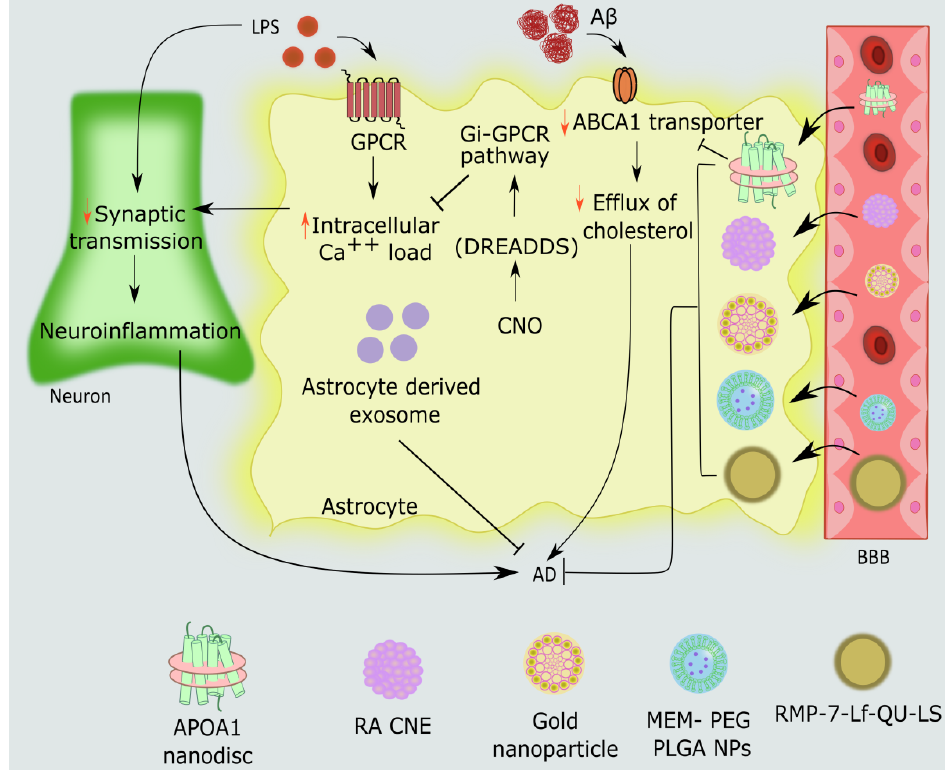
Figure 4. Novel therapeutic strategies to target astrocyte dysfunction in Alzheimer's disease. Reactive astrocytes are brought on by the administration of A β 1–42, and as a result, the levels of the ABCA1 transporter are lowered, inhibiting the release of cholesterol from astrocytes, and hence impeding cholesterol export. When APOA1 nanodiscs cross the BBB, they improve ABCA1 transporters, preventing the reduction of cholesterol efflux in astrocytes caused by exposure to A β 1-42. LPS disrupts the Gi-GPCR pathway, which in turn causes astrocytes to have significantly higher intracellular calcium levels and the accompanying neuroinflammation. Chemogenetic stimulation of the astrocytic Gi pathway by Gi- DREADD agonist CNO reduces intracellular calcium load in hippocampal astrocytes and concomitant neuroinflammation, which enhances synaptic transmission and prevents AD. MEM-PEG-PLGA nanoparticles, glucose-coated gold nanoparticles, RMP-7-Lf-QU-LS, and RA CNE can all cross the BBB and enter astrocytes to prevent A β -induced toxicity in neurons and astrocytes.GPCRs: G protein-coupled receptors; APOA-I: Apolipoprotein A-I; ABCA1:ATP-binding cassette transporter A1; NLP: Nanolipoprotein particle; DREADDs: Designer receptors only activated by designer drugs; CNO: Clozapine N-oxide; Gi: Inhibitory G protein; MEM-PEG-PLGA-NPs: Memantine–polyethylene glycol–Polylactic-co-glycolic nanoparticles; RMP-7-Lf-QU-LS: